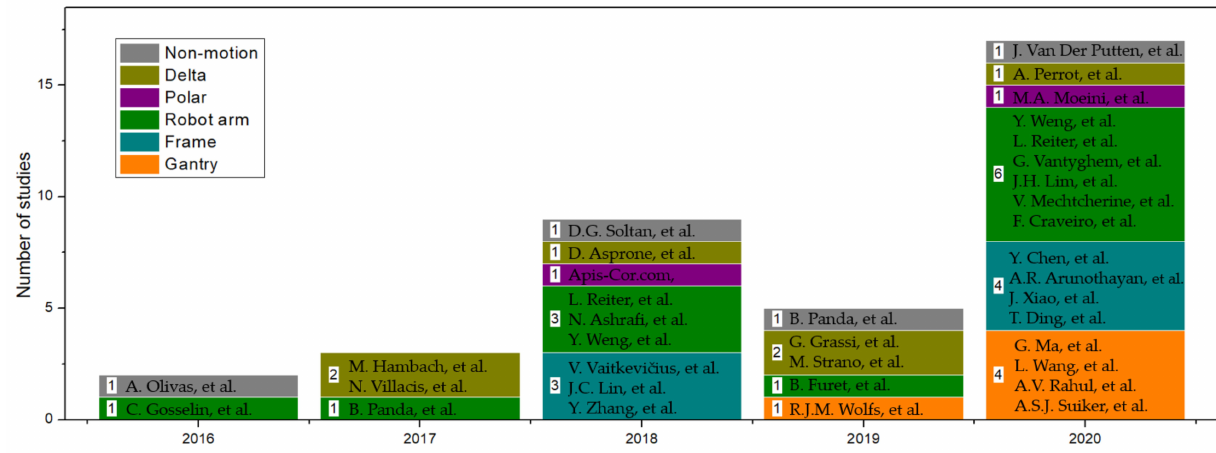
Figure 3. Numbers of studies with types of motion systems from Table